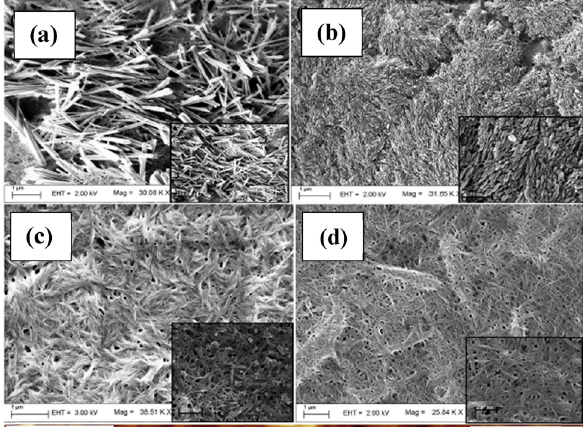
Figure 3: FESEM micrographs of CNCs modi fi ed with di ff erent acids: ( a ) sulfuric acid, ( b ) hydrochloric acid, ( c ) phosphoric acid, and ( d ) nitric acid. Adapted from ref. [ 32 ]